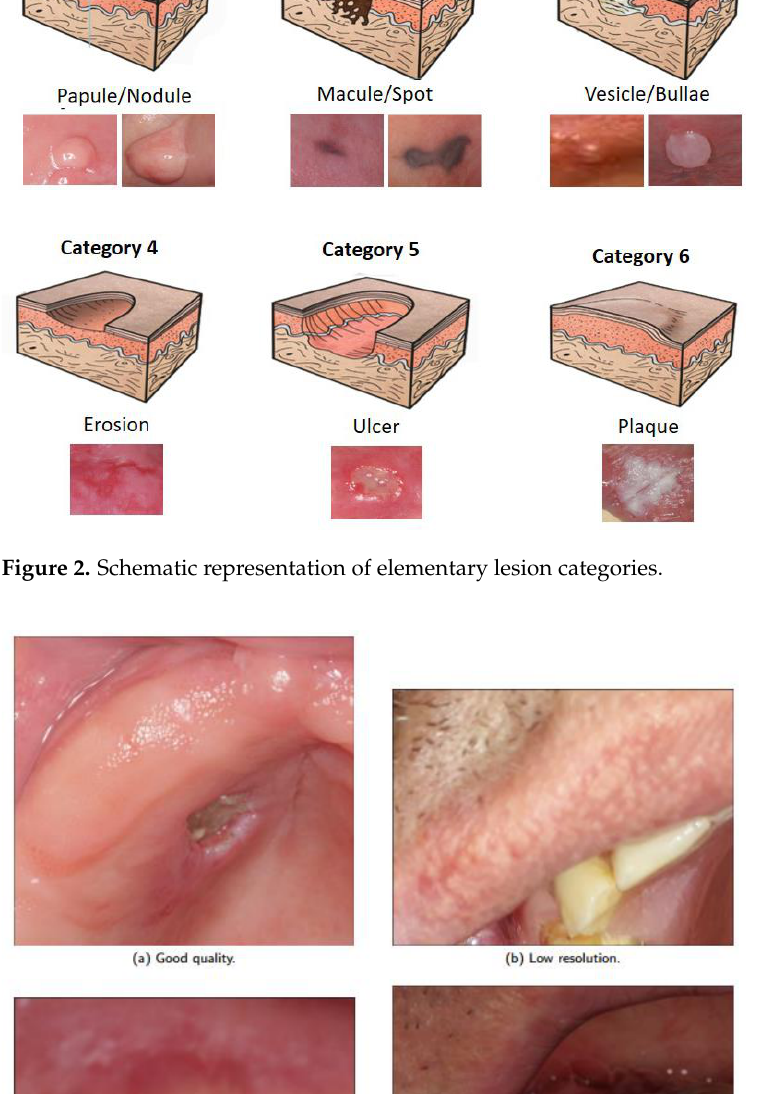
Figure 2. Schematic representation of elementary lesion categories.